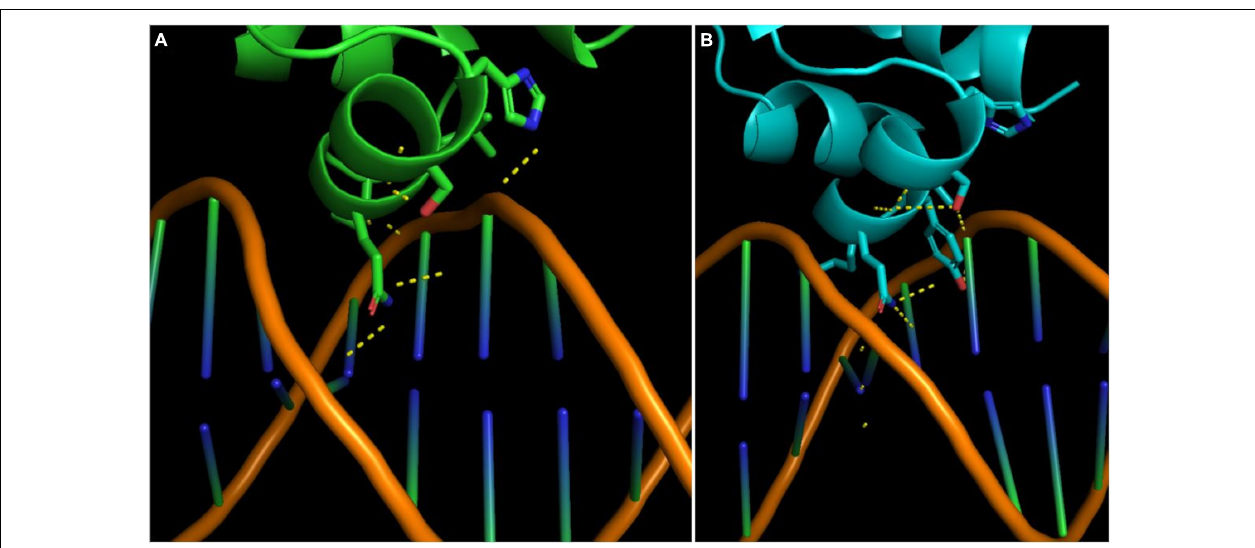
FIGURE 2 | Impact of the Ser37Tyr mutation observed in the DDAC-adapted IT-BIO-DC-139 strain on DNA binding. Carbon atoms are shown in green for the parental strain (IT-FOX-FE-63) (A) and in blue for the DDAC-adapted strain IT-BIO-DC-139 (B) . The calculated hydrogen bonds are indicated by a yellow dotted line. Only the scaffold is shown for the double-stranded DNA (dsDNA) molecule. The dsDNA is docked in the parental strain; the modification of the residue 37 alters the conformation of the protein at the DNA-binding site, leading to a reduction of affinity for the DNA strands (affinity score of –82.9 compared with –104.2 from the fepR model of the parental strain). (DDAC, didecyldimethylammonium